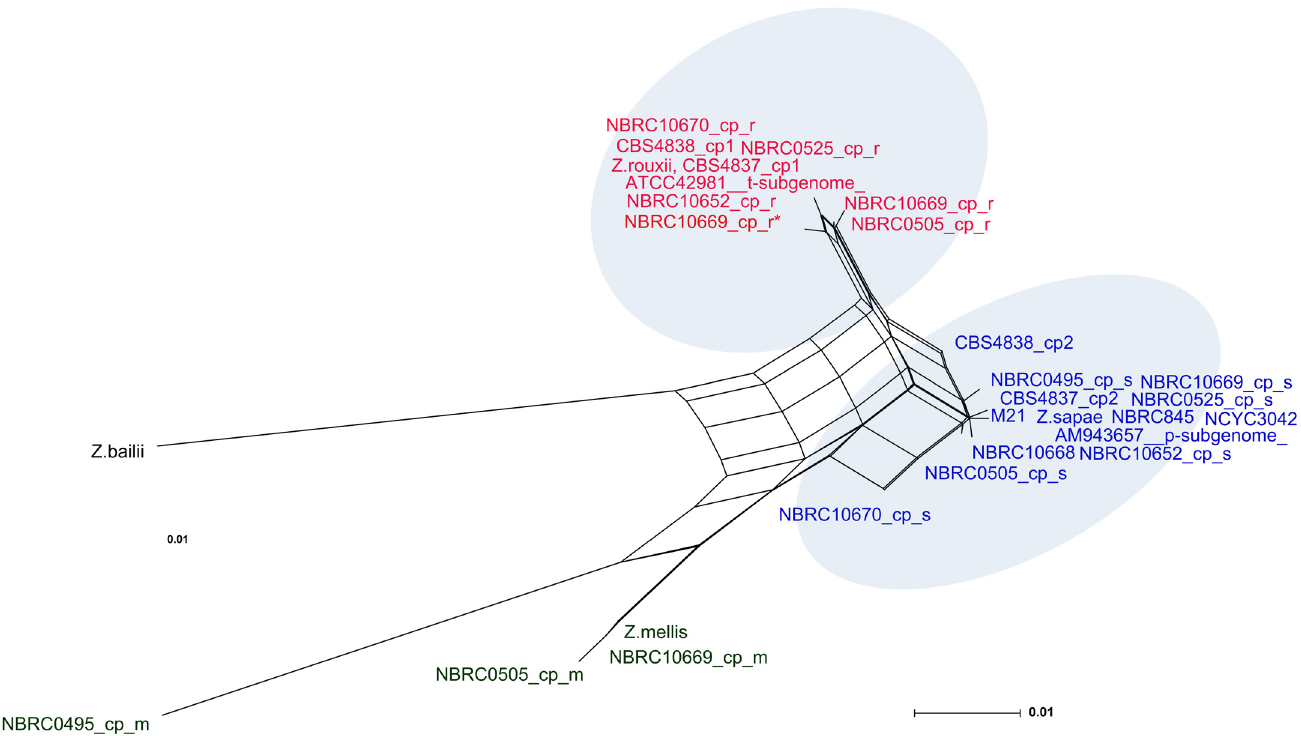
Fig 5. Neighbor-net network of D1/D2 sequences. A dataset of 30 intra-genomic and inter-strain variants is considered. The scale bar represents the split support for the edges. For display purposes, bootstrap scores are not shown. Strains belonging to Z . sapae and Z . rouxii clusters are denoted by red and blue labels,